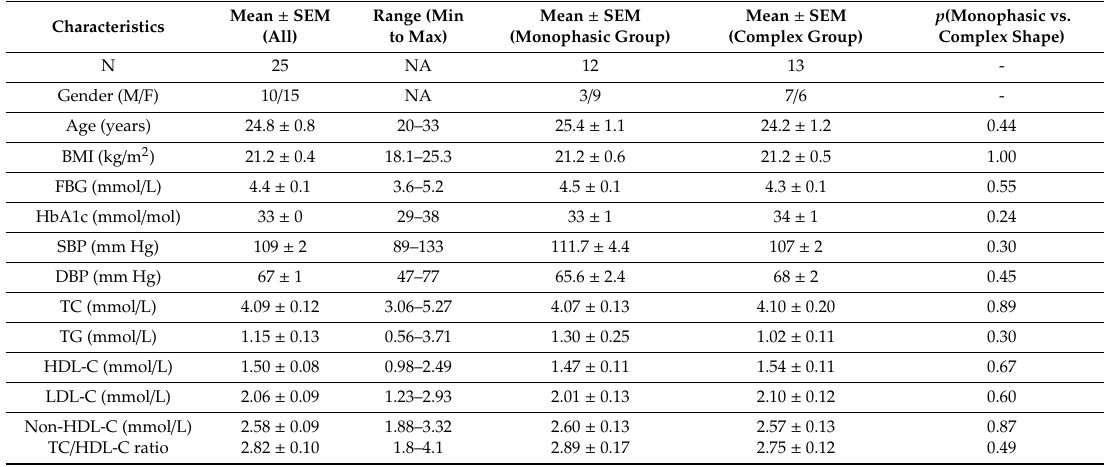
Table 1. Baseline characteristics of participants ( n = 25) classified as having either a monophasic ( n = 12) or complex ( n = 13) glucose curve shape during the control